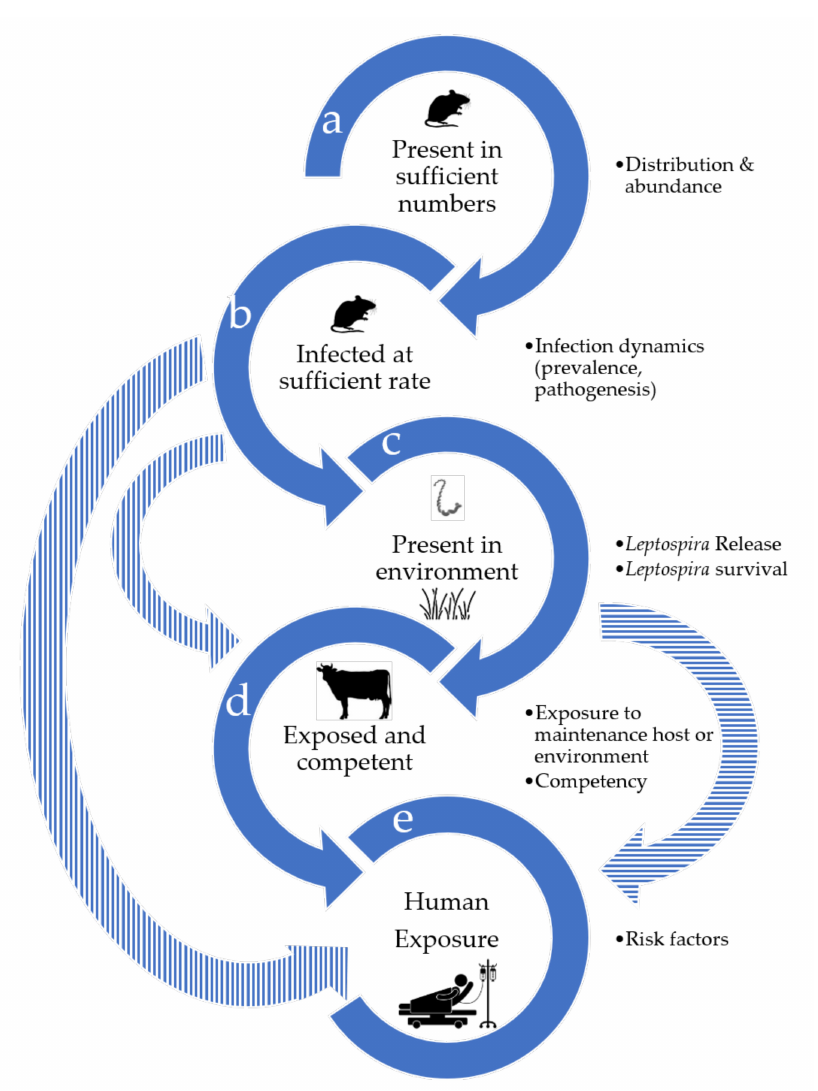
Figure 1. Theoretical barriers to Ballum spillover from wildlife to humans included in the literature search. This diagram assumes that wild mammals are maintenance hosts, cattle act as bridge hosts, and humans are target hosts. The plain arrows indicate the longest chain of transmission leading to spillover, while the striped arrows show possible shortcuts. The bullet points detail what is included in each